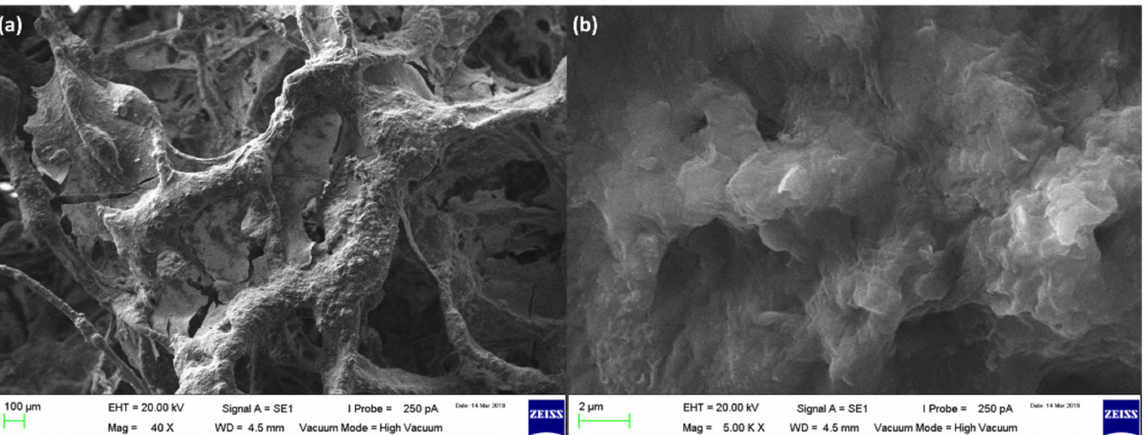
Figure 2. SEM results of biofilm developed at the surface of the rotating disk; ( a ) at 40 × and ( b ) at 5000 ×